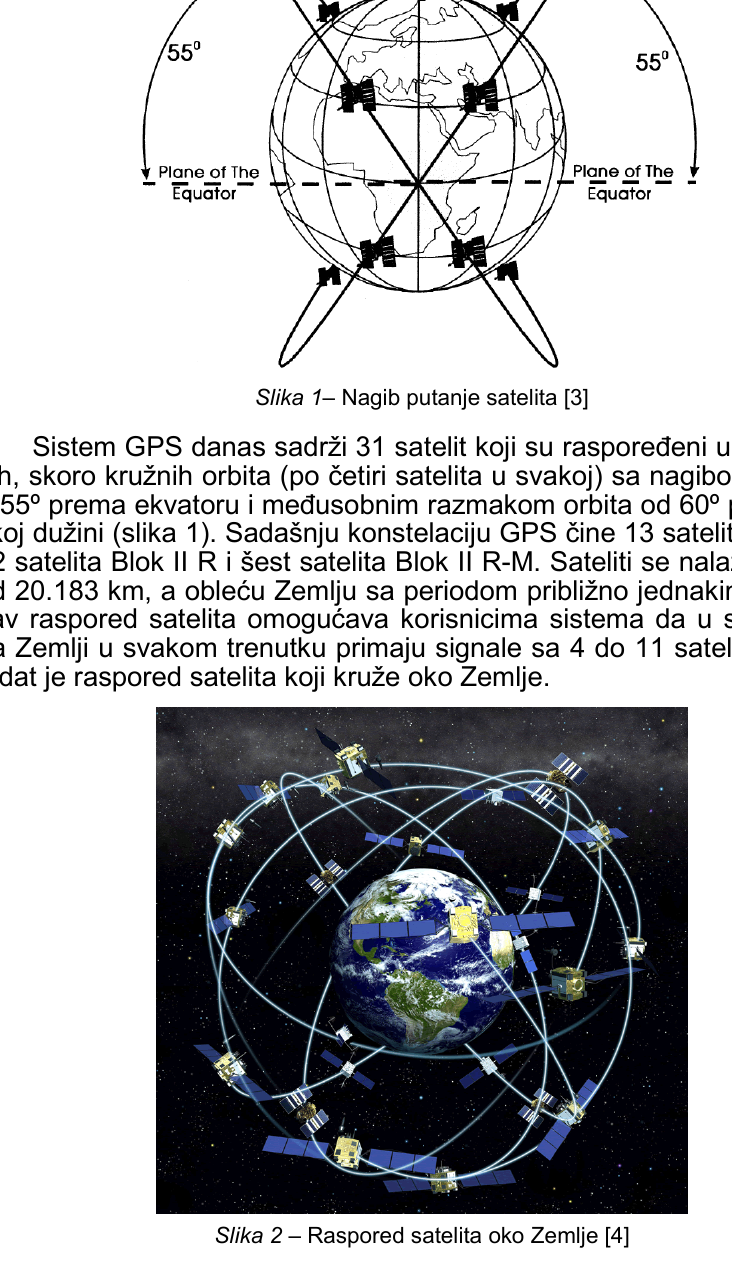
Slika 2 – Raspored satelita oko Zemlje